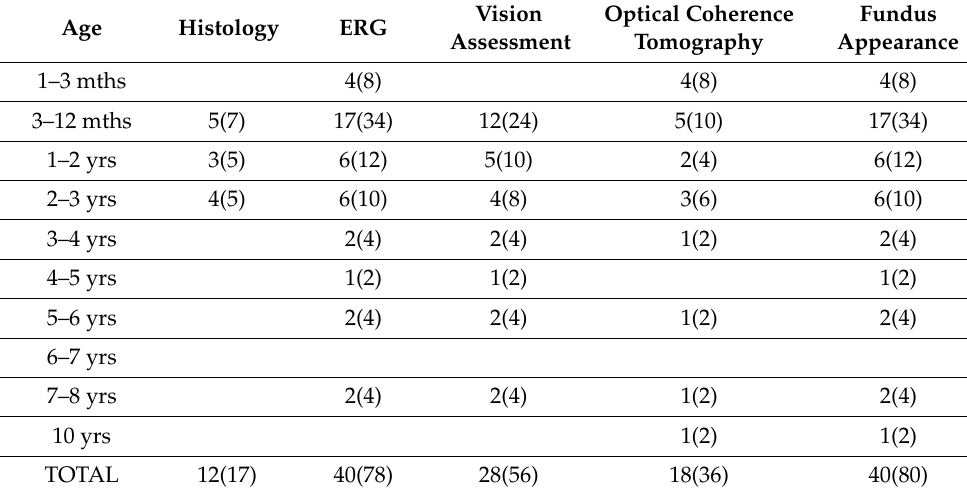
Table 1. Rpe65-deficient dogs and (eyes) used in this study. Age Histology ERG